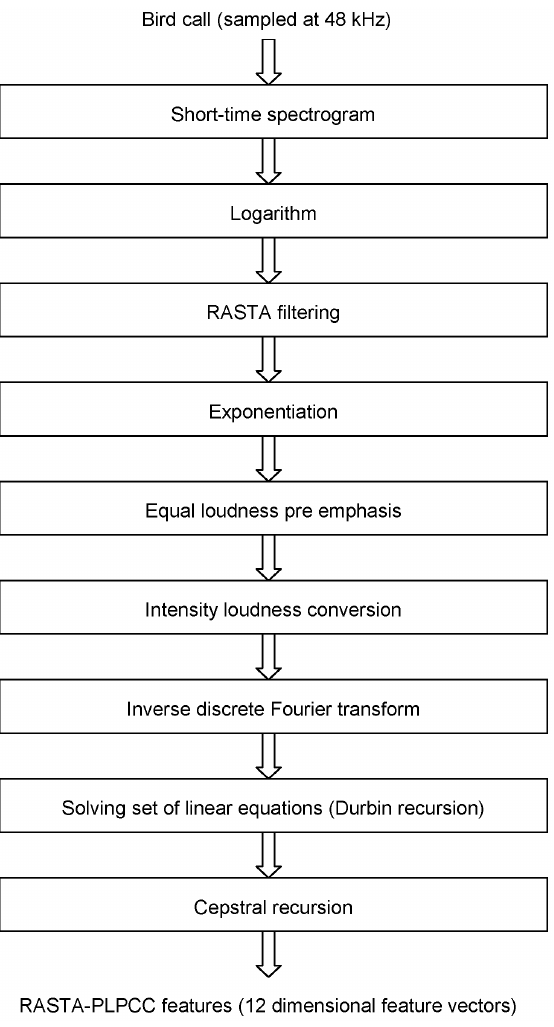
Figure 3. Flow chart showing the procedure for extraction of RASTA-PLPCC feature